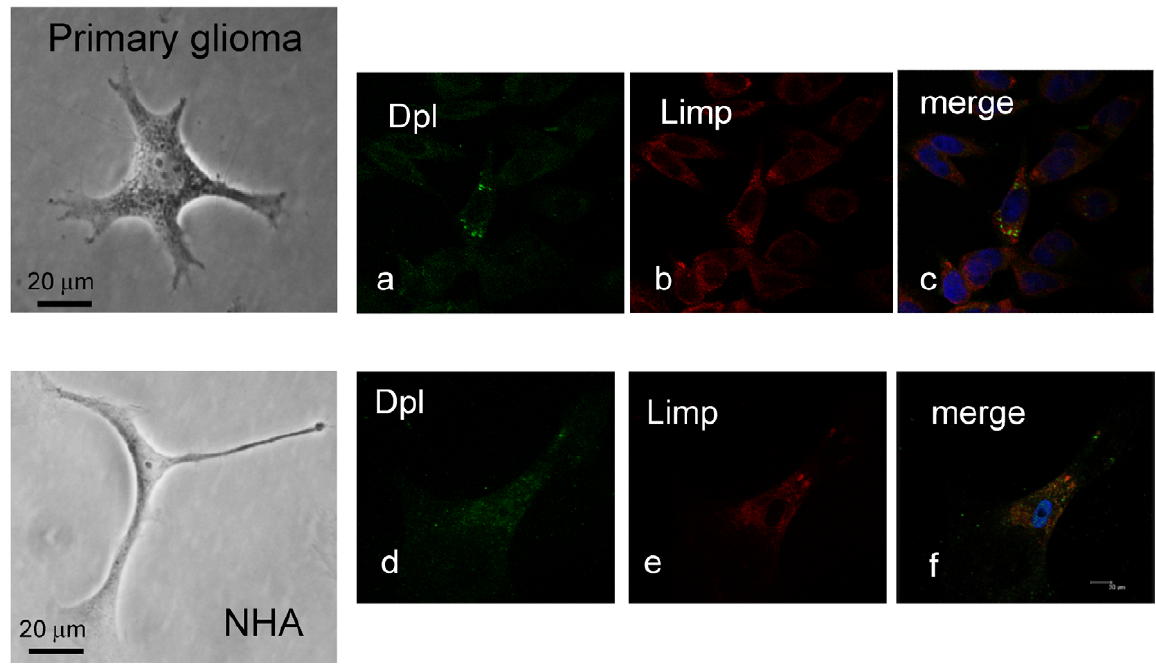
Fig. 3. Dpl expression in a primary glioma and in normal human astrocytic cells. At their second culture-passages, cells were fixed and incubated with primary antibodies, specifically goat polyclonal Limp-2 (Abcam) and mouse monoclonal anti-Dpl D7C7 antibodies. Species-specific Alexa Fluor 488 and Alexa Fluor 633 secondary antibodies (Invitrogen) were employed, as illustrated in Table 1. Slides were incubated with ProLong Gold antifade reagent with DAPI (Invitrogen) to stain nuclei (blue). The cell morphology and fluorescence were observed with a confocal fluorescence microscope (Leica, original magnification, 63 × ). The scale bars are